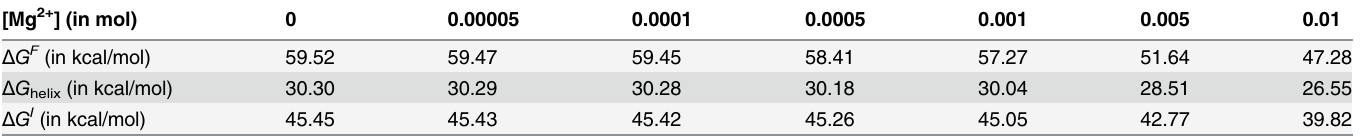
Table 2. The table shows the calculated electrostatic free energies of the T2 pseudoknot (the folded state, Δ G F ), the 24-nt helix ( Δ G helix ) and the in- termediate state ( Δ G I ) under various [Mg 2+ ]. [Mg 2+ ] (in